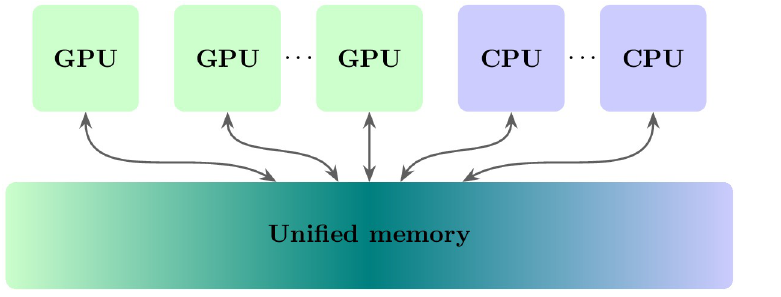
Fig 3. The unified memory.